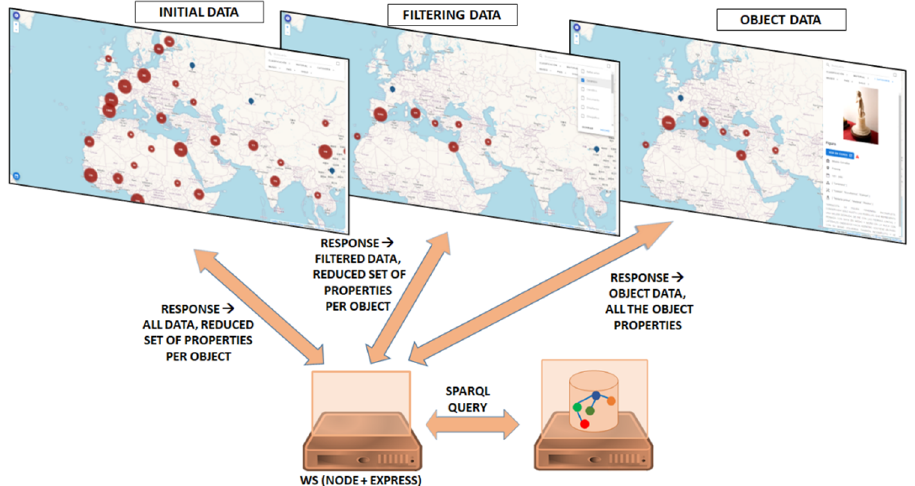
Figure 3. Diagram with the Knowledge graph connection from the web application user interface.